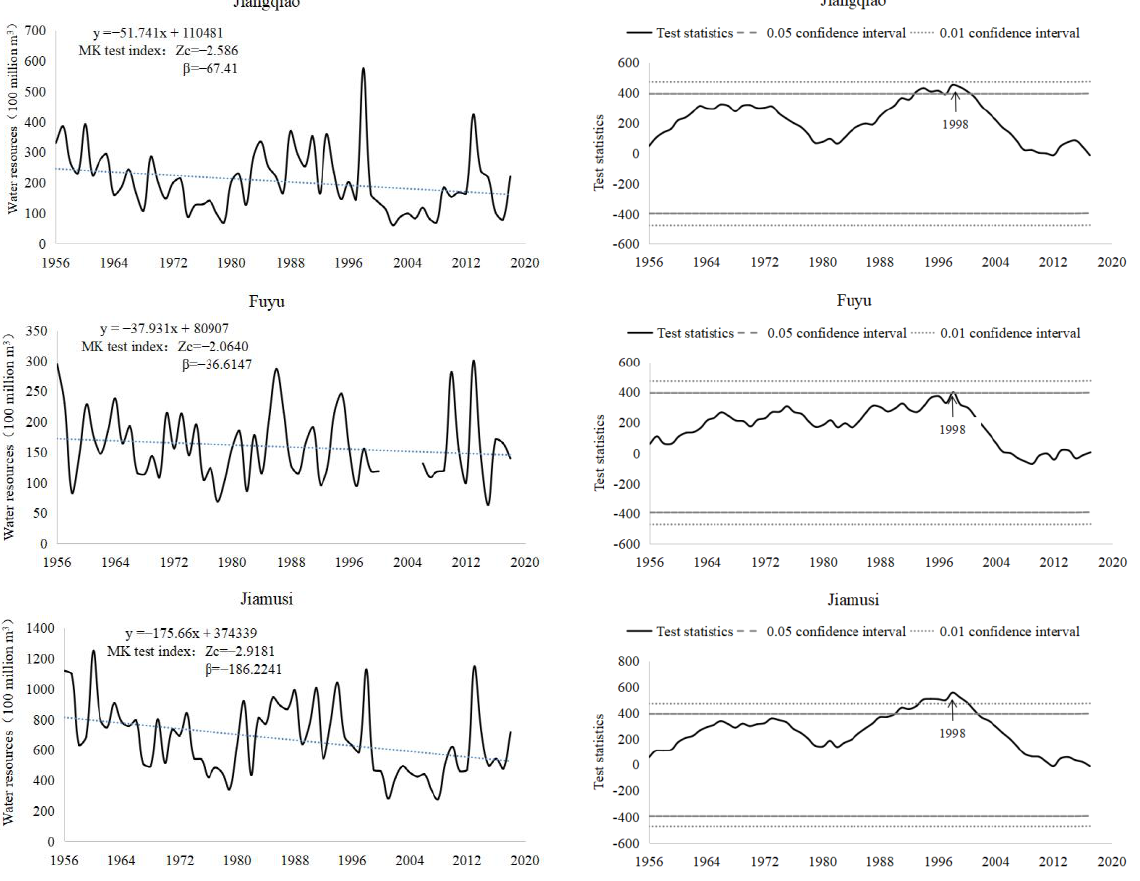
Figure 3. Trend and mutation analyses of measured annual runoff in the SRB.